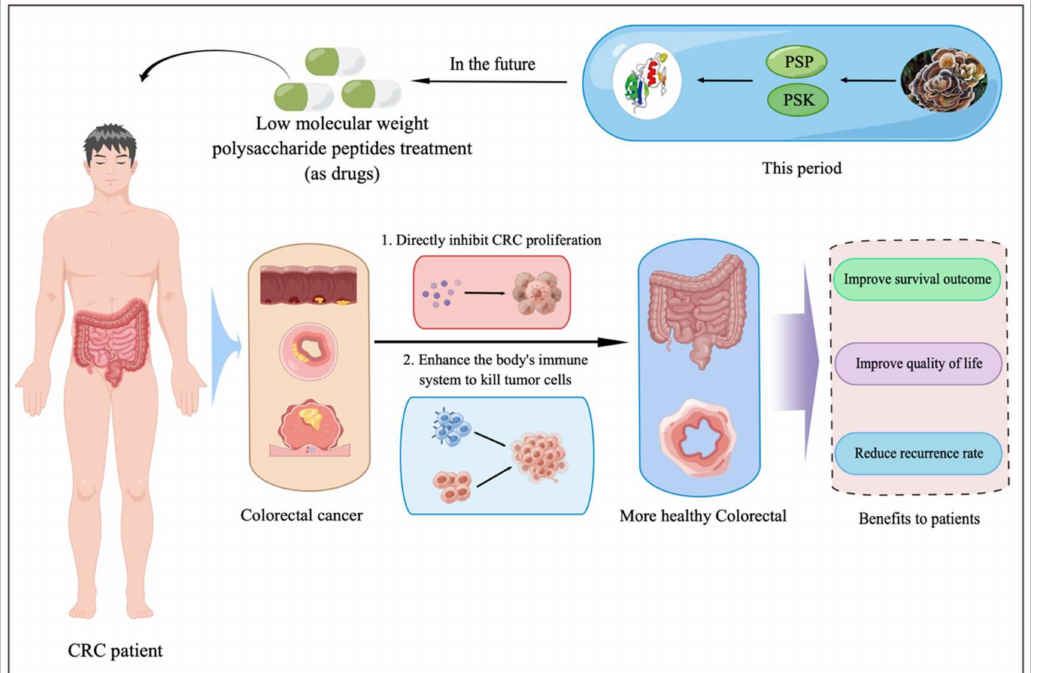
Figure 2. Prospects of musarin (the 3D structure was derived from our previous study [12]) and LMW-polysaccharide peptides applicated for CRC patients’